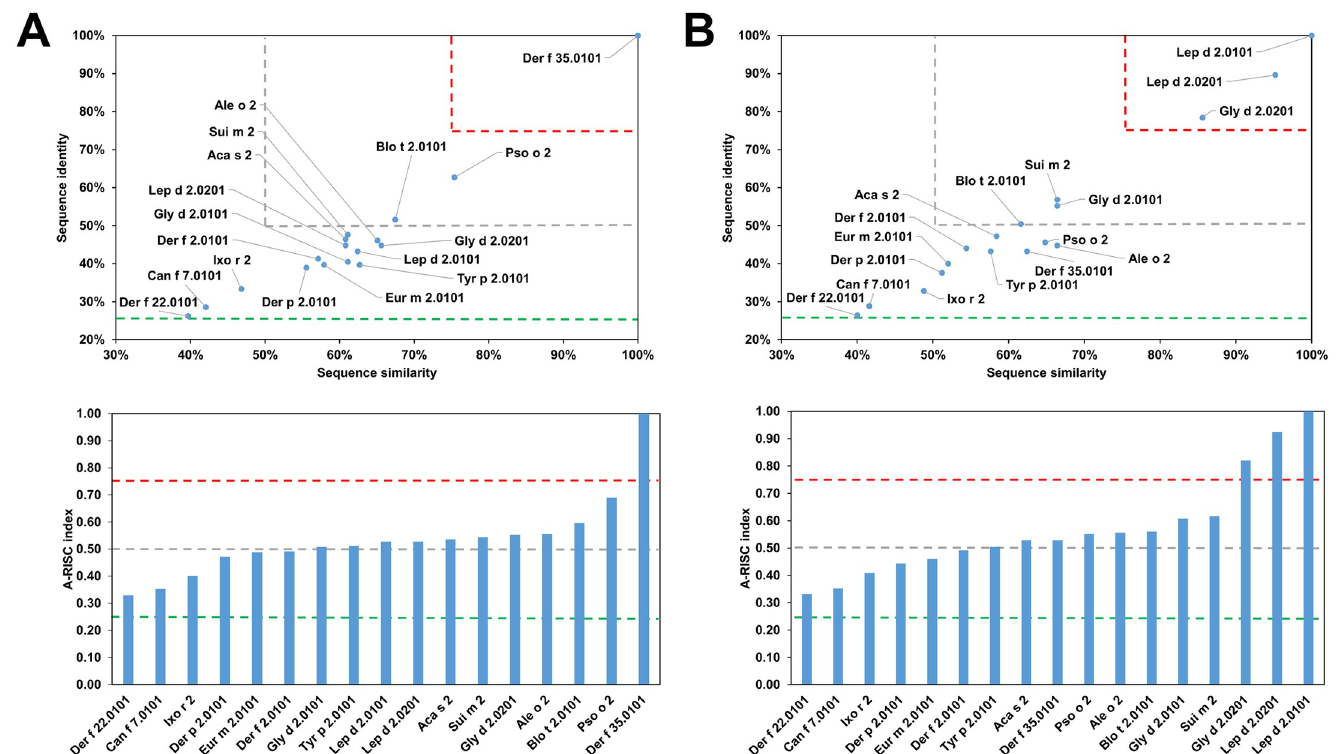
Fig 5. Plots showing relative homology and A-RISC indexes of allergens from the NPC2 family. Comparison of family members to Der f 35.0101 (A) and Lep d 2.0101 (B). Red, gray, and dark green dashed lines indicate respectively 75%, 50% and 25% sequence identity and similarity, or 0.75, 0.50 and 0.25 A-RISC values.